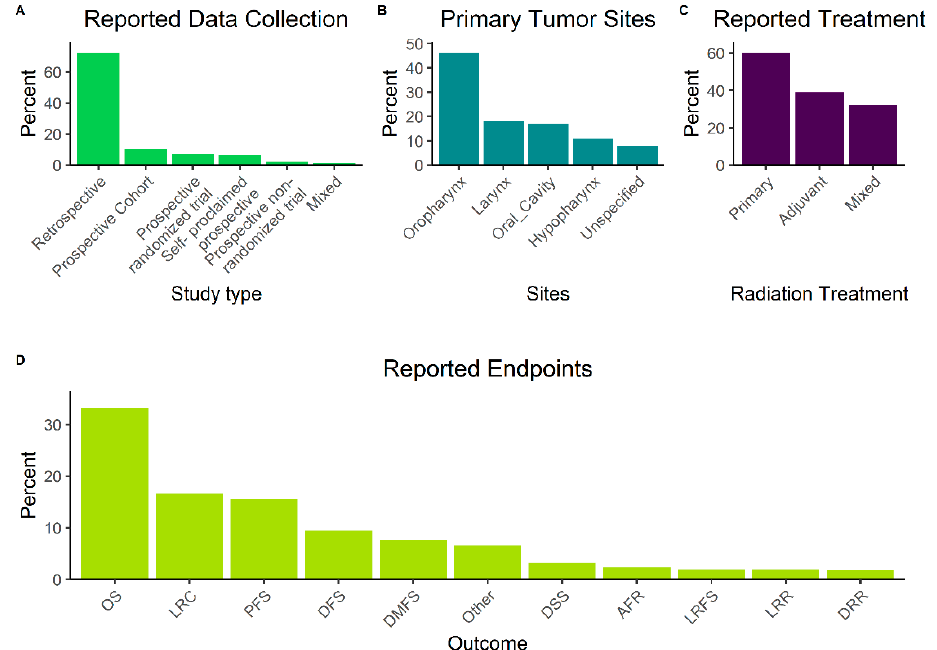
Figure 3. Method of data collection for included studies ( A ). Reported anatomical site of primary tumor ( B ). Type of radiotherapy applied to included patients ( C ). Reported Outcomes and end- points ( D ). AFR—Any failure rate, DFS—Disease-free survival, DMFS—Distant metastasis- free sur-